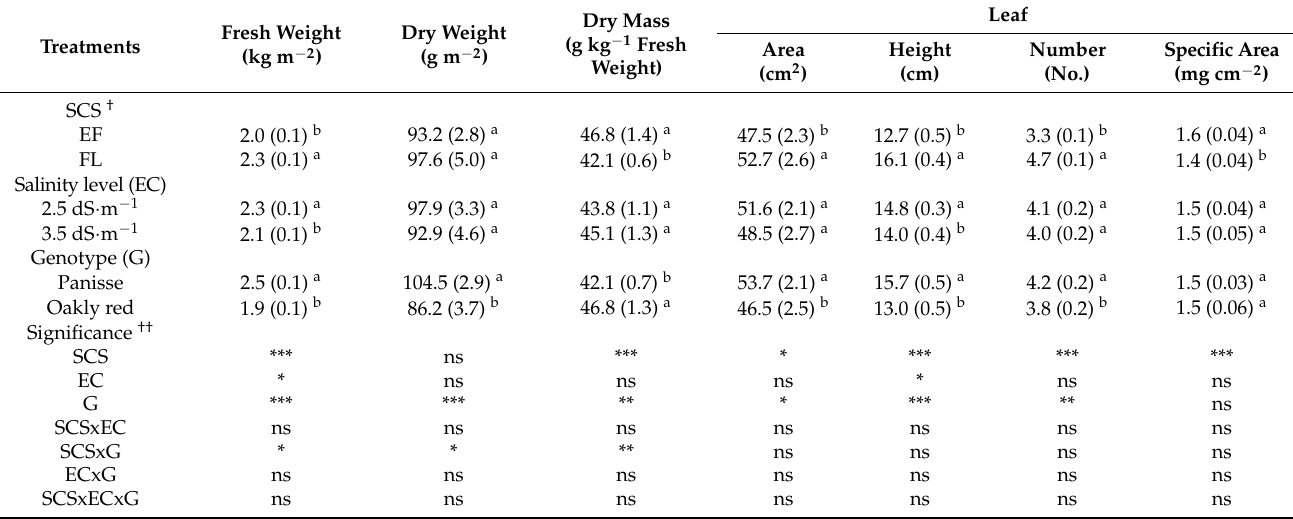
Table 1. Effect of soilless cultivation system (SCS), salinity level of nutrient solution (EC), and genotype (G) on yield and bio-morphological traits of oak-leaf lettuce leaves (autumn cycle). In brackets, the standard error of the mean.